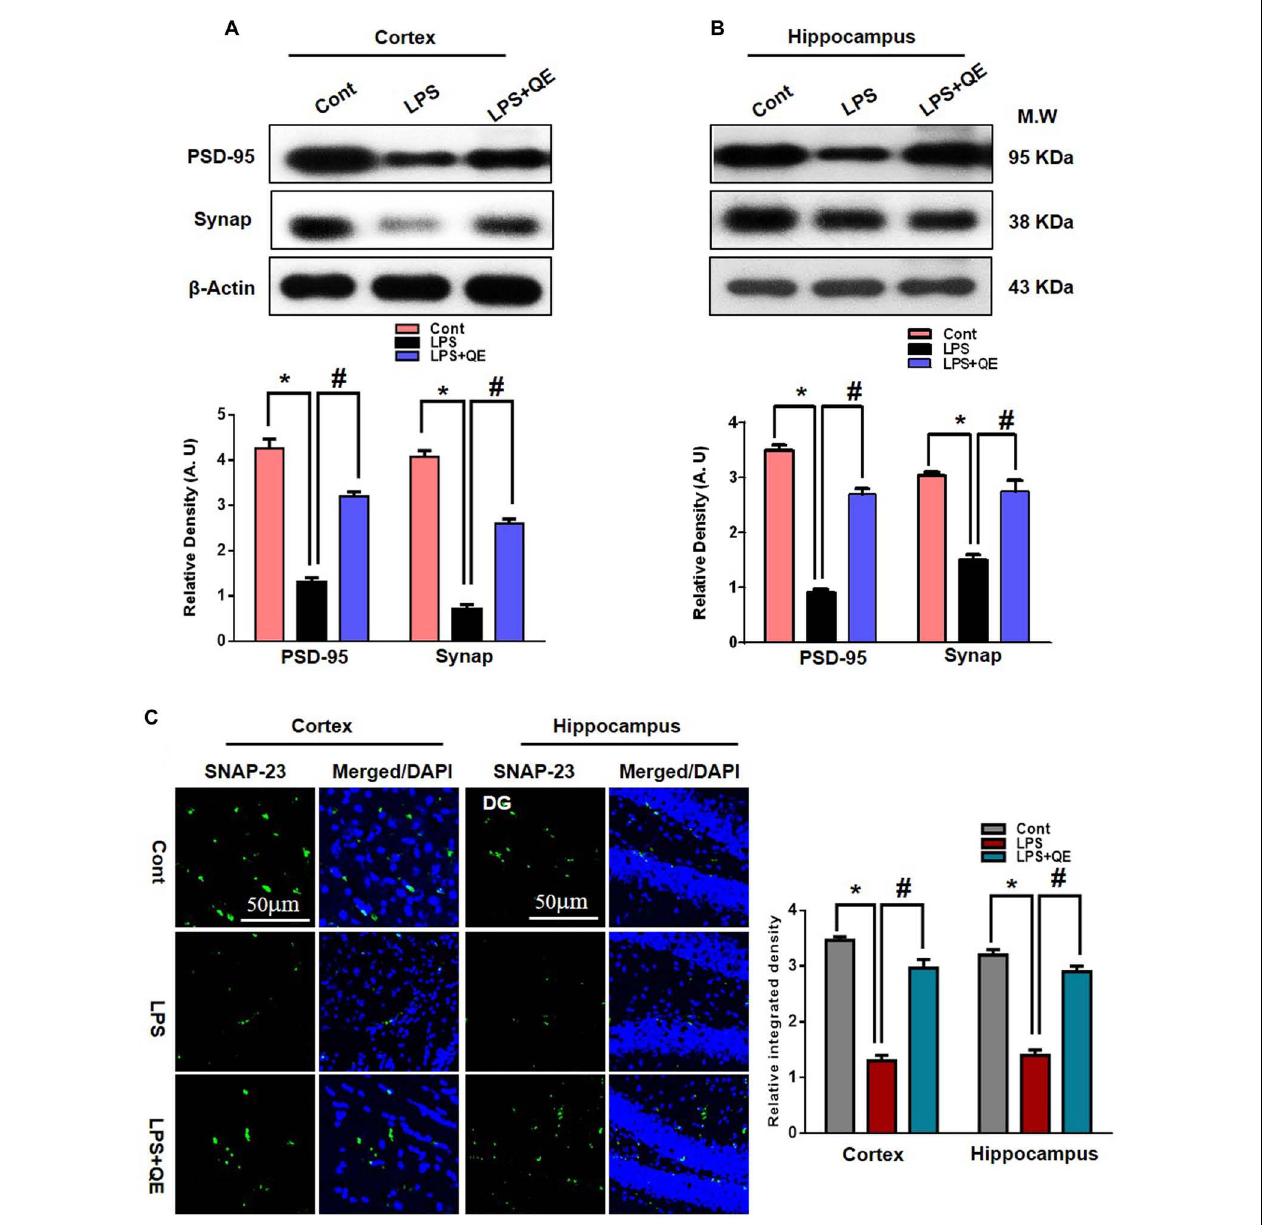
FIGURE 3 | Quercetin improved the pre- and postsynaptic markers in the LPS-treated mice. (A,B) Western blotting of the proteins Synap and PSD95; their differences in the cortex and hippocampus of mouse brains are represented by a histogram. β -Actin was used as a loading control. The quantified density values are shown in arbitrary units (A.U.) as the means ± SEM for the respective shown protein (8 mice/group). (C) Representative immunofluorescence images and the quantified histogram of SNAP-23 in the cortex and hippocampus of adult mice (5 mice/group). Magnified 10 × . Scale bar = 50 µ m. The expressed data are relative to the control. ∗ Significantly different from the control; # significantly different from LPS-treated group. Significance: P <